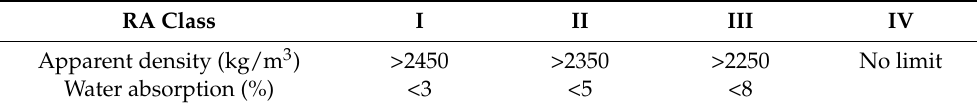
Table 2. Physical property requirements of the performance-based classification